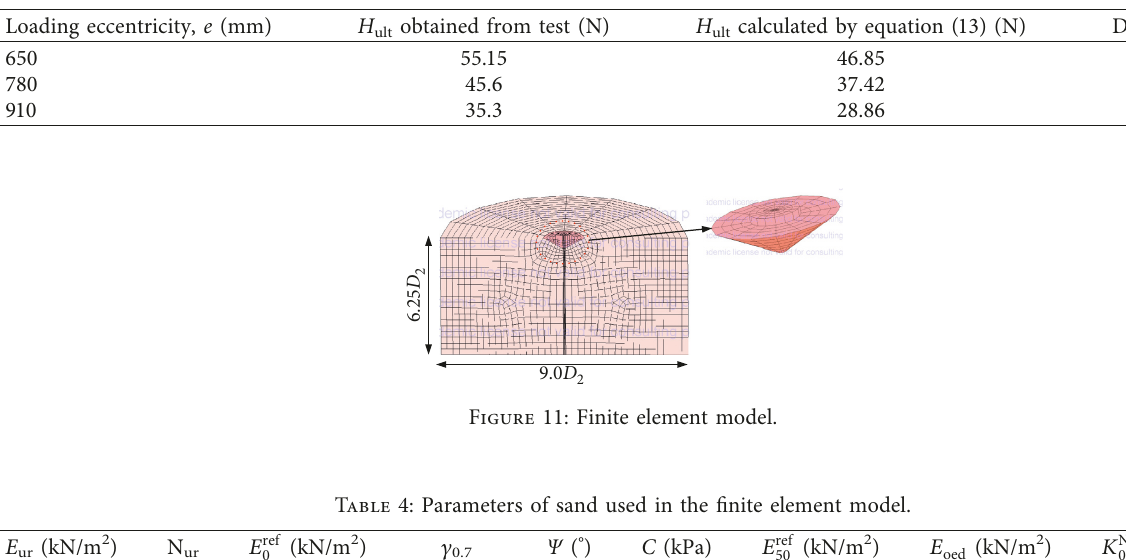
Table 3: Comparison of ultimate horizontal bearing capacity.